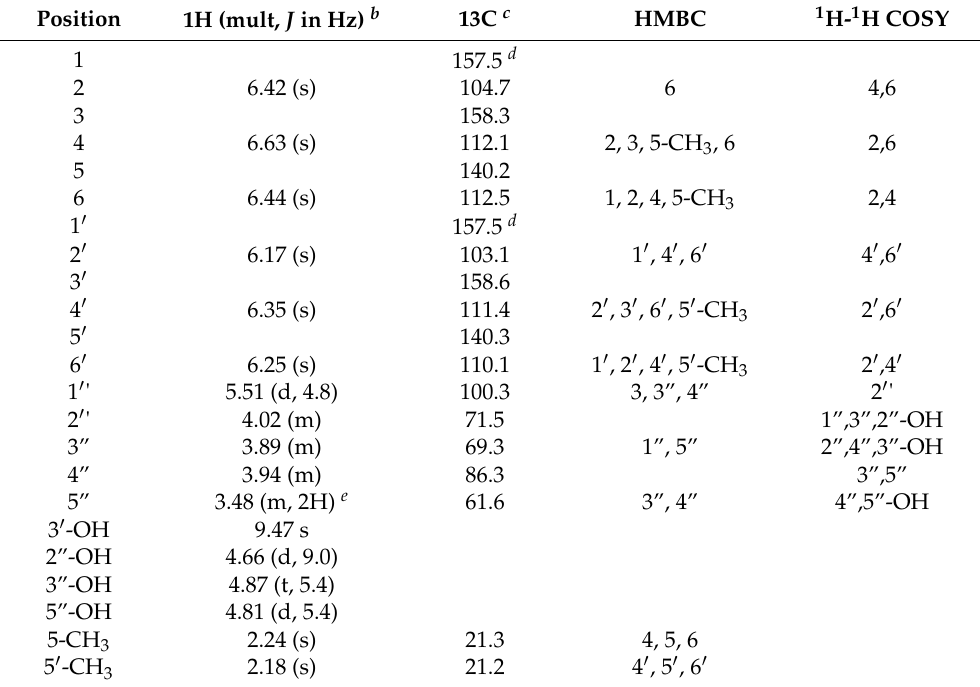
Table 1. NMR spectroscopic data of compound 1 (DMSO- d 6 ) a